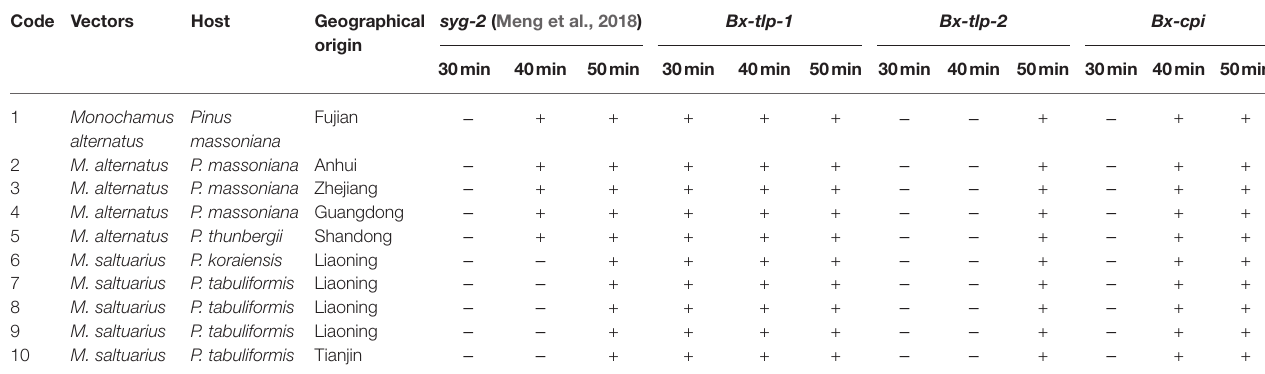
TABLE 4 | LAMP-based detection of Bursaphelenchus xylophilus from Monochamus alternatus or M. saltuarius . +, LAMP amplicon detected; − , LAMP amplicon not detected. Code